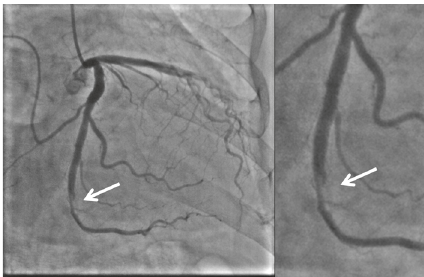
Figure 2: Angiography after stenting showed mild luminal narrow- ing with a dissection at the distal left circumflex artery (arrow).